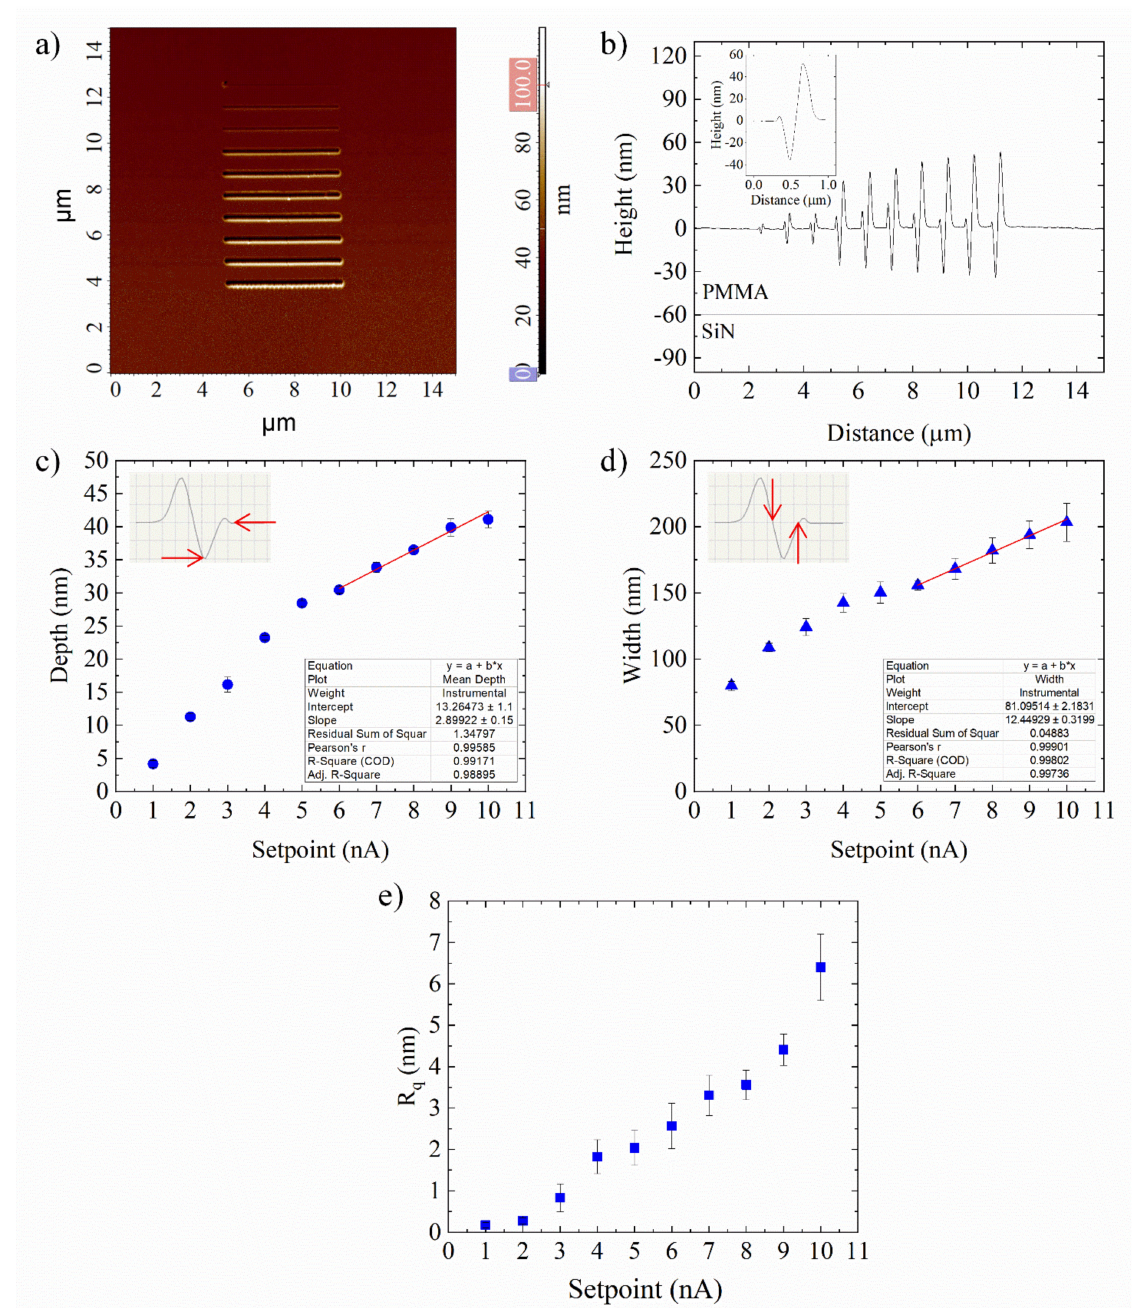
Figure 3. ( a ) SensHeight AFM images of 5 µ m long nanogrooves patterned on a PMMA surface and the corresponding cross section profiles ( b ); in the inset, the V-shaped profile of groove corresponding to 10 nA setpoint (17.94 µ N force). Depths ( c ) and widths ( d ) of nanogrooves on PMMA for each setpoint. The definition of measured depths and widths are schematically shown in the respective insets. Red line for depths ( c ) and widths ( d ) is best linear fit for higher setpoint value (6 nA ÷ 10 nA). ( e ) Roughness (R q ) mean values, obtained by averaging 10 different point in the channels man- ufactured setting different setpoints. The data reported in ( c – e ) were statistically significant for p <